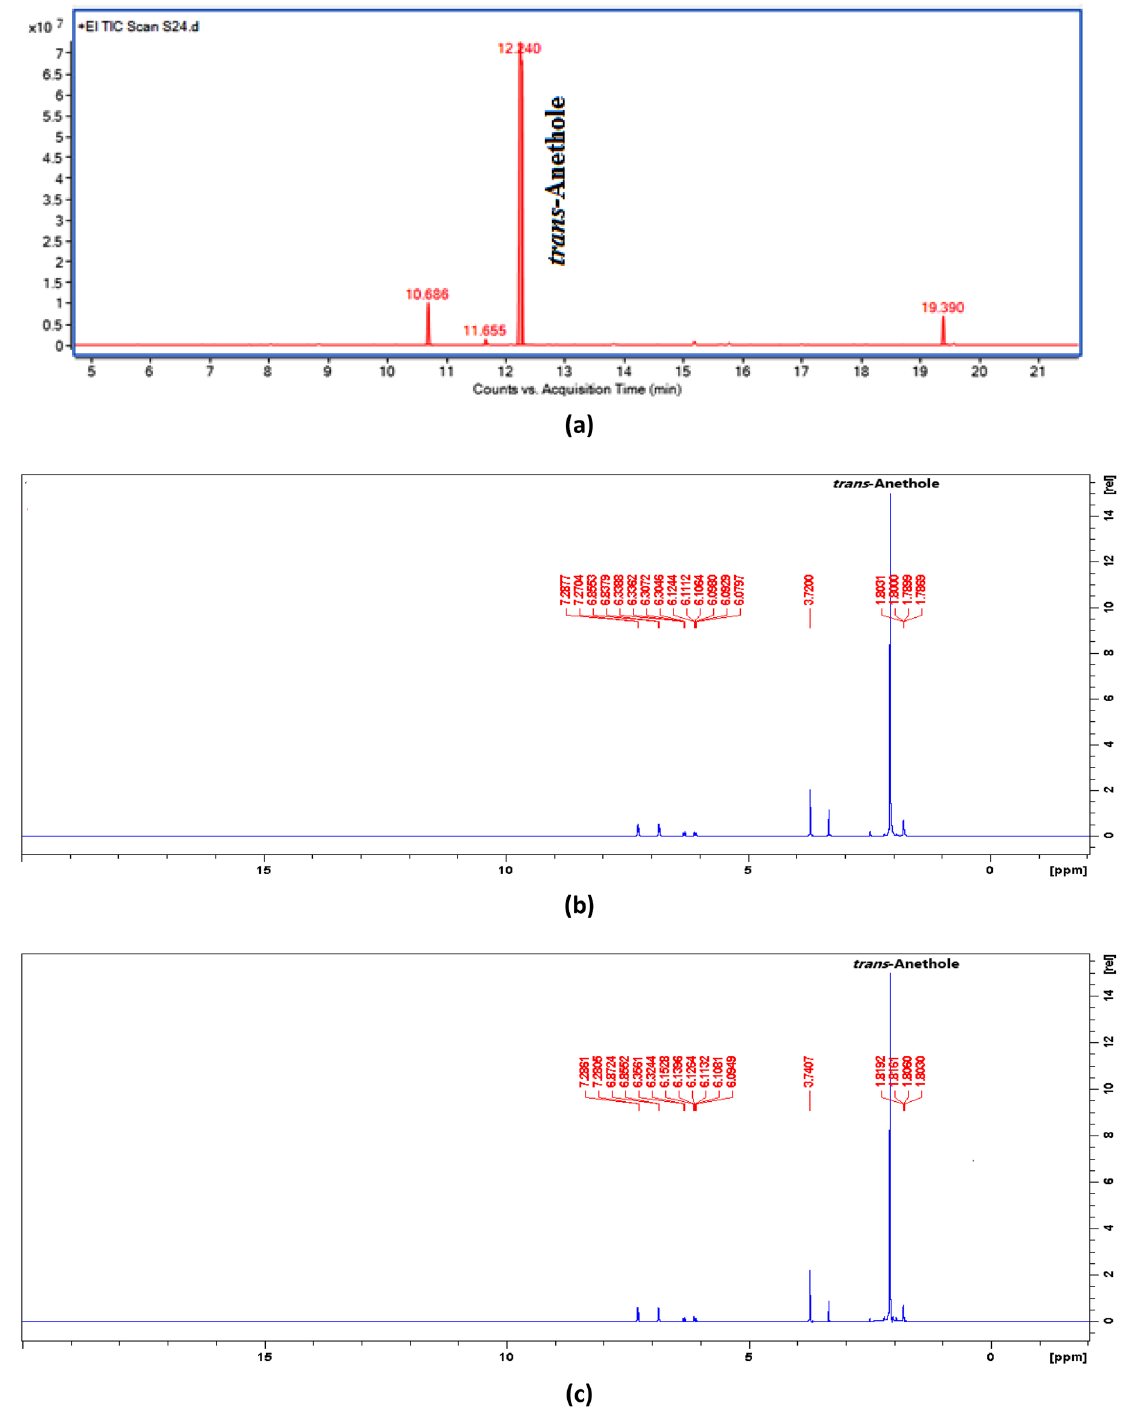
Figure 1. ( a ) Chromatogram of GC/MS analysis of ARCHEO; ( b ) NMR spectra of ARCHEO; ( c ) NMR spectra of the pure standard compound